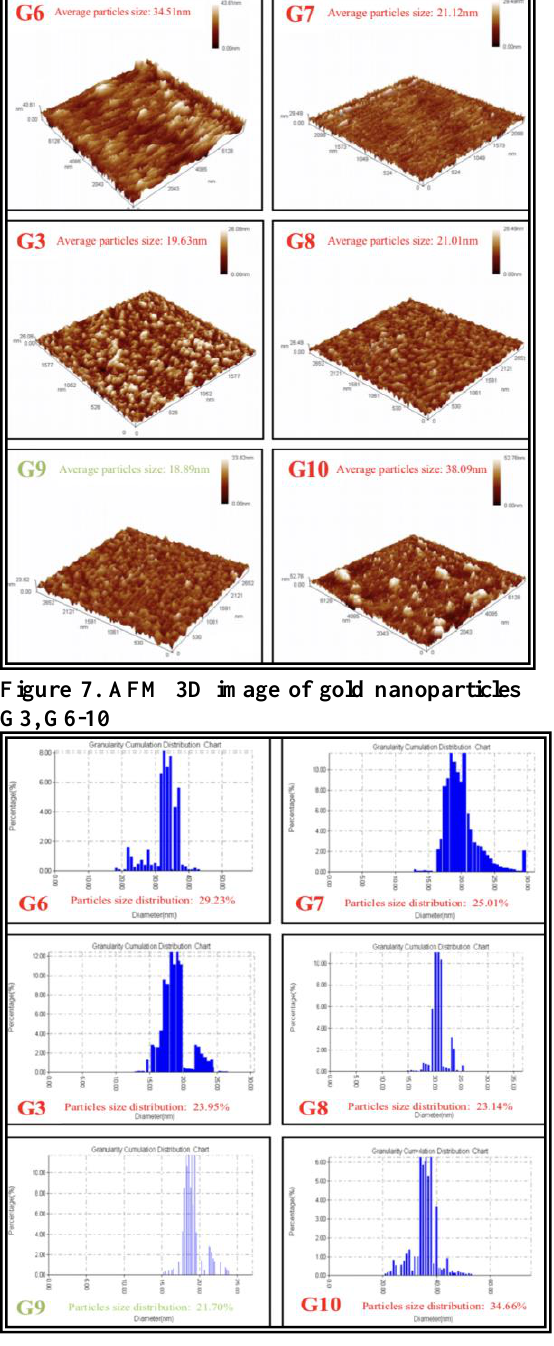
Figure 9. AFM 3D image of gold